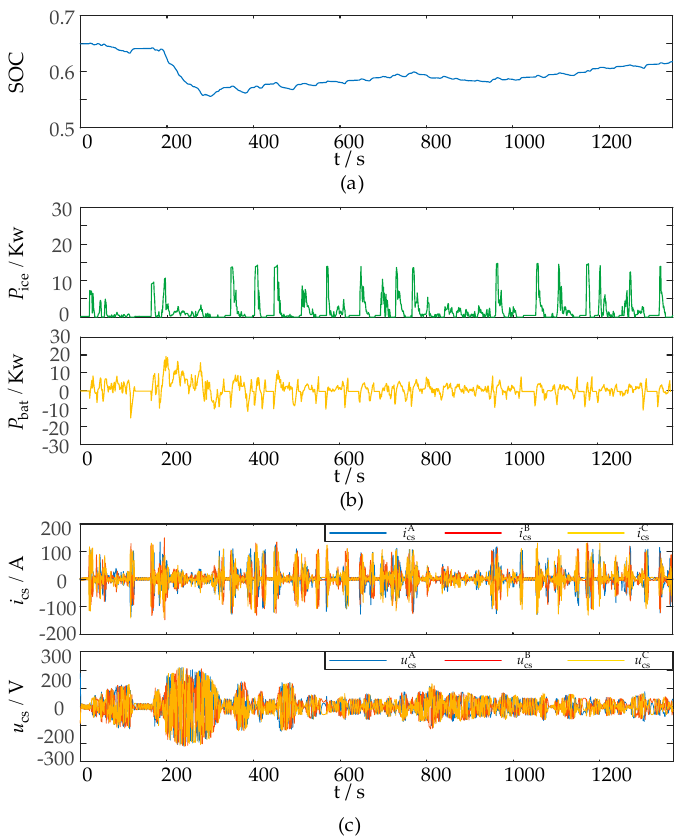
Figure 16. The SOC, power, current and voltage waveforms during the UDDS driving cycle: ( a ) the SOC waveform of battery; ( b ) the power waveforms of ICE and battery; ( c ) the current and voltage waveforms of CRPM-DFM.